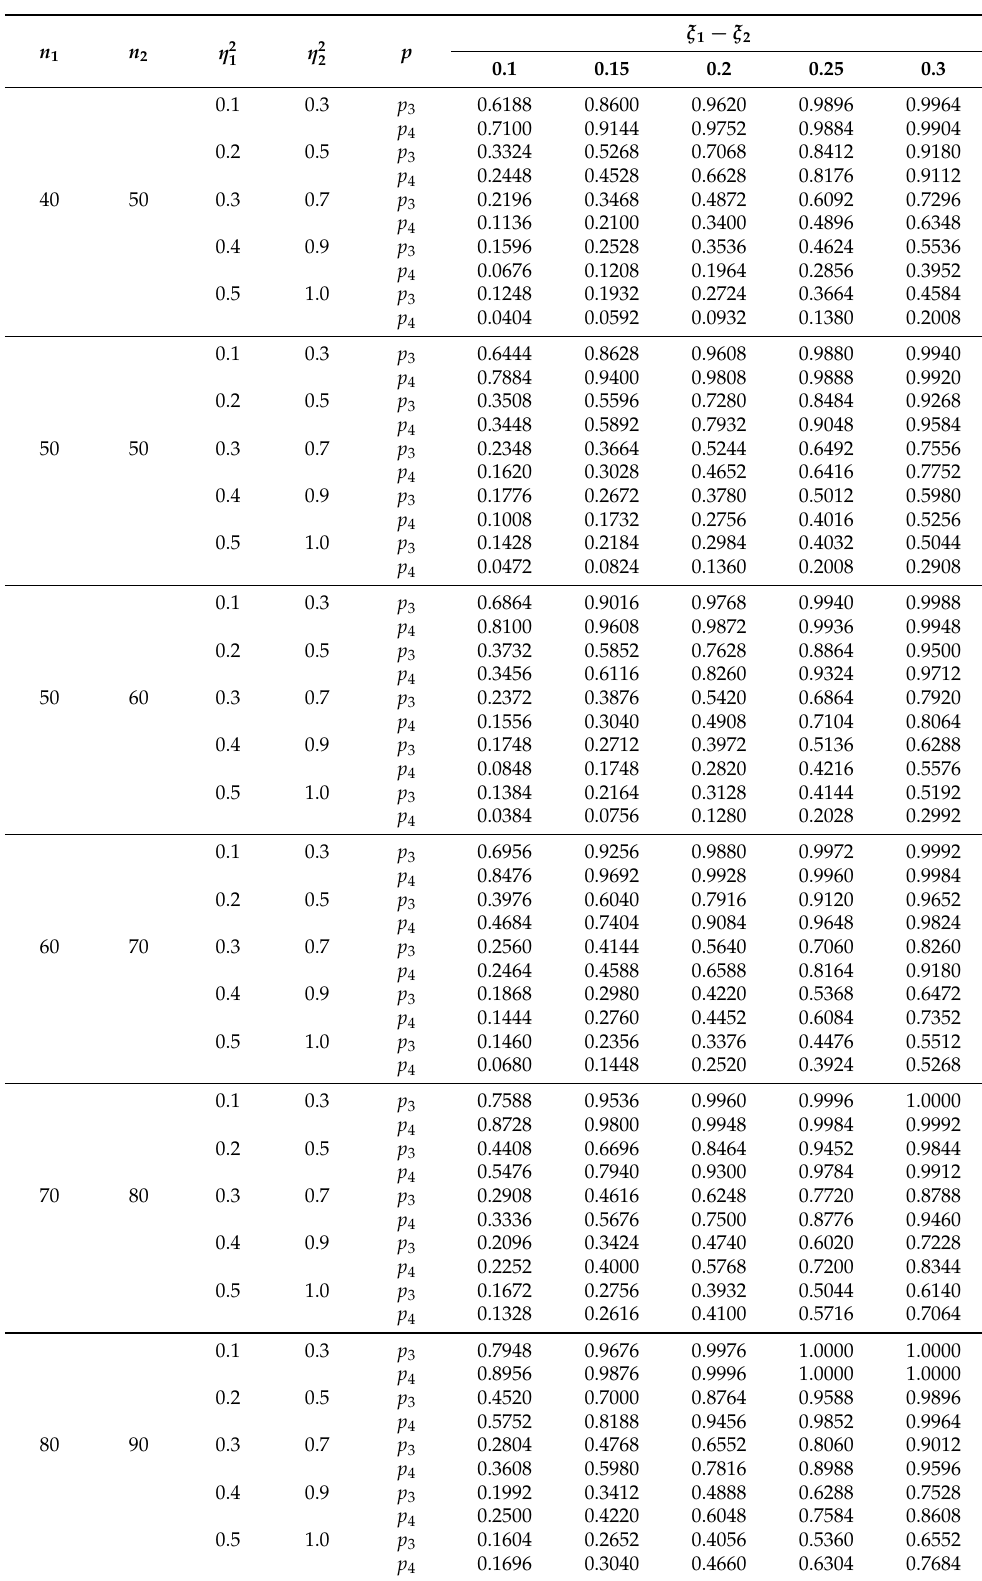
Table A6. Simulated powers of hypothesis testing problem (27) ( λ 1 = 6, λ 2 = 8 )